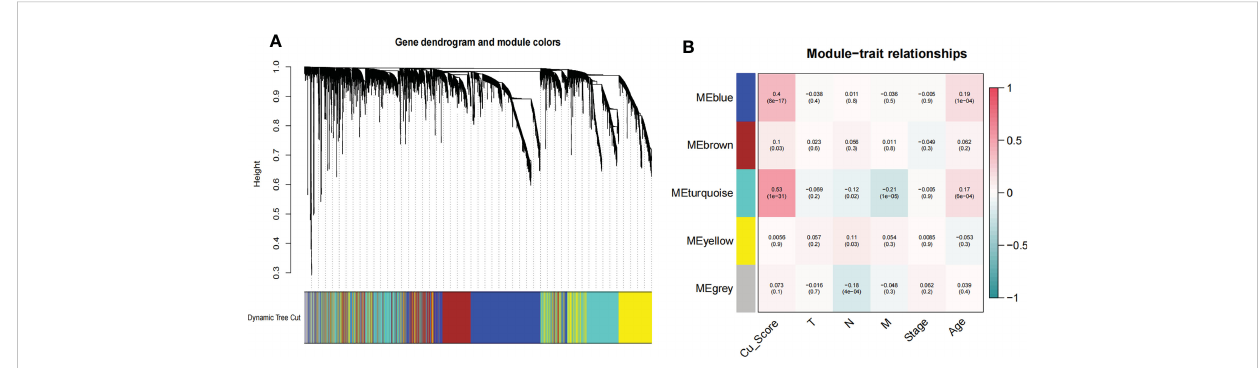
FIGURE 1 WGCNA for the uproplasia-related genes. (A) Cluster dendrogram generating gene modules. (B) Correlation analysis of modules and Cu_score, and other clinical